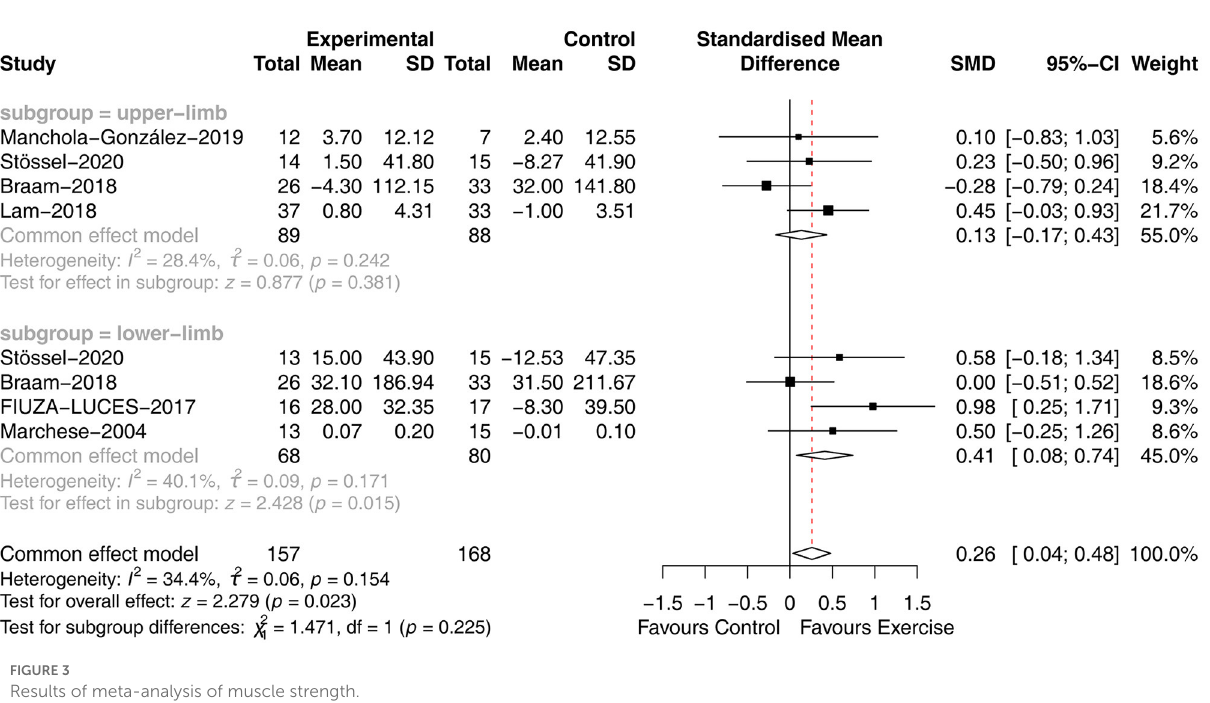
FIGURE3 Results of meta-analysis of muscle strength.